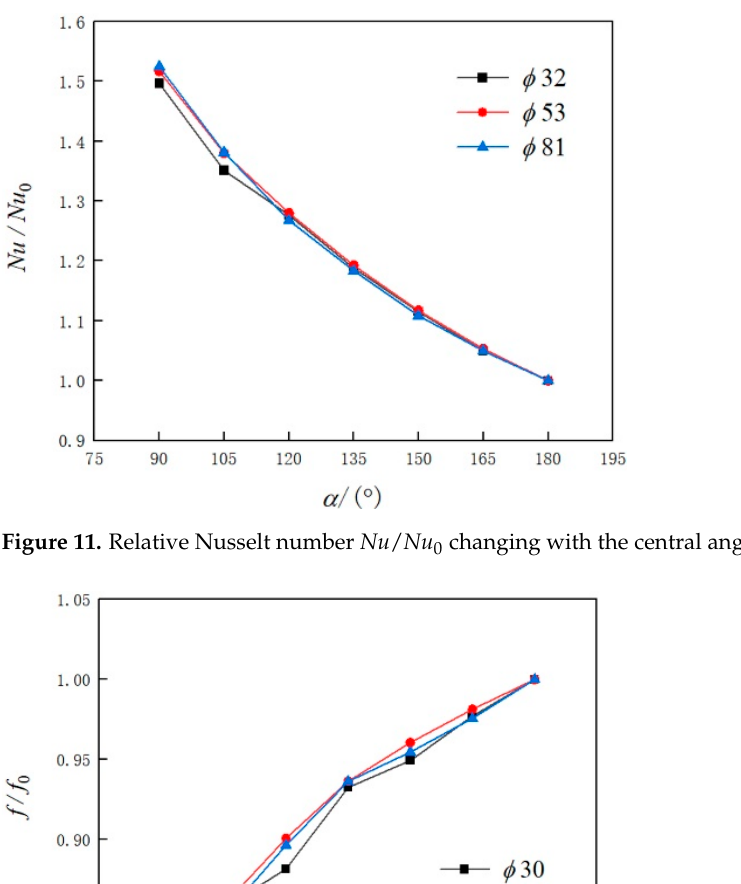
Figure 10. Relative Nusselt number Nu / Nu 0 changing with the central angle α for straight pipes.